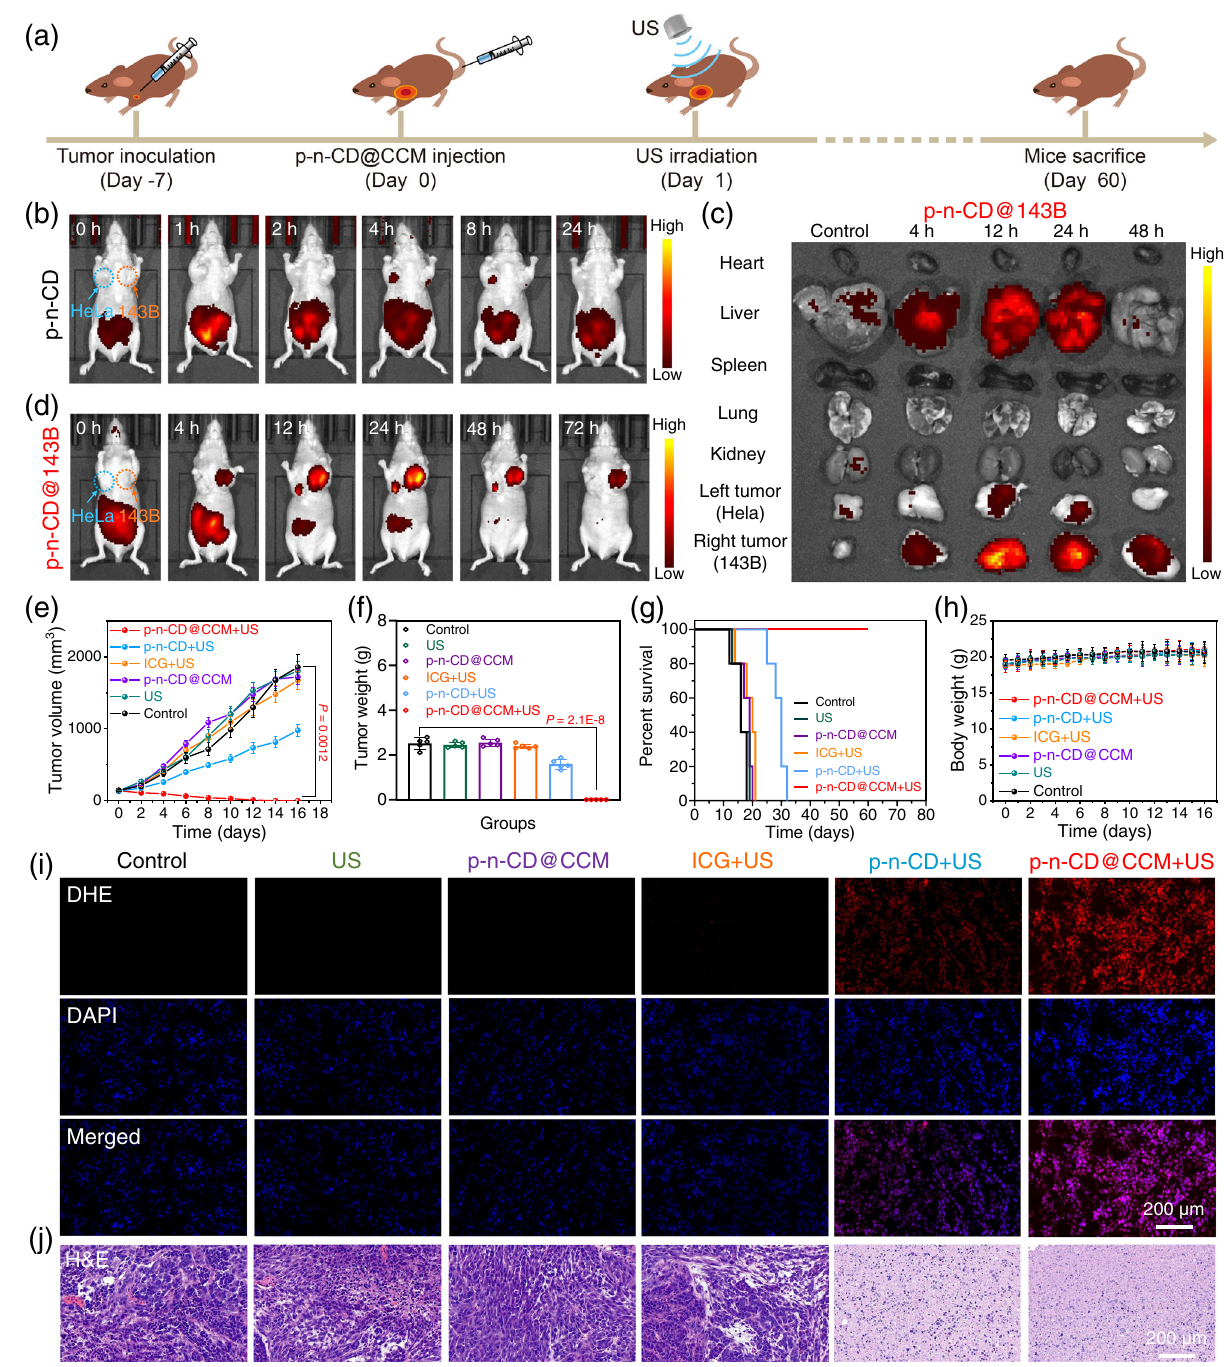
Fig. 6 | In vivo precision SDTofp – n-CD@CCM. a SDT protocol of p – n-CD@143B (2.0g/kg) under single US irradiation on 143B tumor-bearing mice. b In vivo NIR imaging of mice with free p – n-CDs. c Tumor-speci fi c in vivo NIR imaging of mice with p – n-CD@143B. d Ex vivo NIR imaging of major tissues and tumors with p – n- CD@143B. e 143B tumor growth curves of mice after indicated treatments ( n =5 biologicallyindependent samples). f 143B tumor weight after indicated treatments ( n =5 biologically independent samples). g Survival curves of mice after indicated